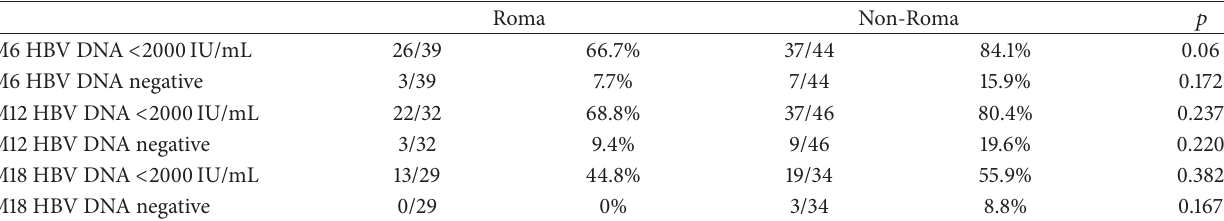
Table 3: HBV DNA during treatment and followup, per-protocol data.